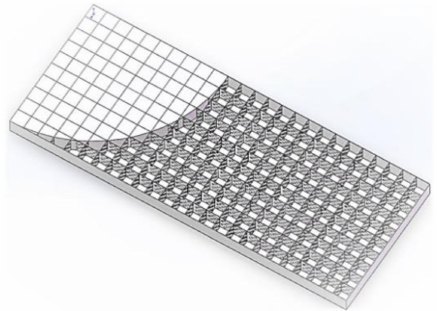
Figure 2. Structure diagram of multi-cavity steel–concrete composite